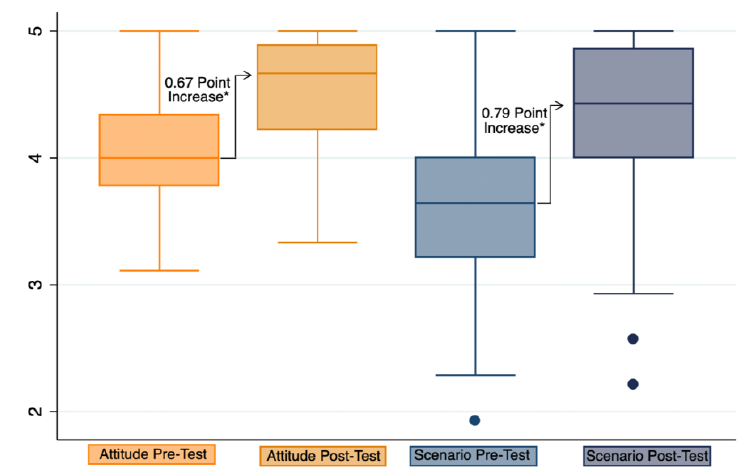
Figure 2. Box plot of the average pre-test and post-test responses. Note: Attitudes towards adolescents and women unplanned for pregnancy, and unsafe abortions. Scenario: Response to example of scenarios on abortions. * p -Value ≤ 0.001